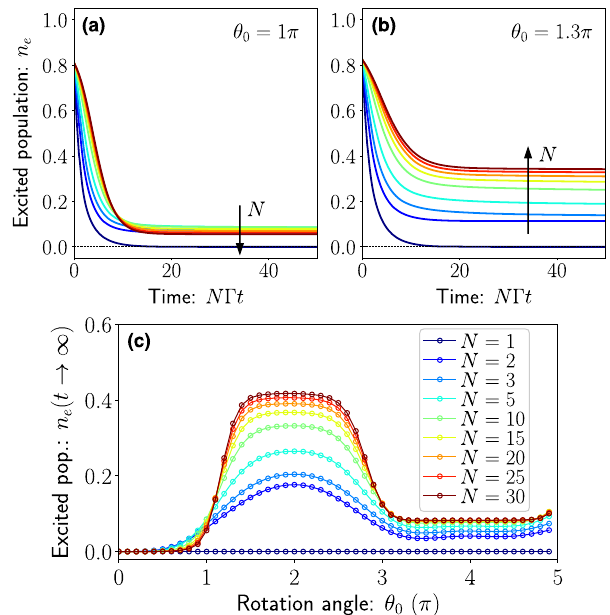
FIG. 5. N dependence of dark steady state. ED simulations for a 1 = 2 and F 3 = 2 which starts with six-level system with F ffiffiffi g ¼ e ¼ p − j g 2 all atoms in the ground state ðj g − 1 and is 1 = 2 i k Þ = = 2 i k ˆ H ˆ H Ω = 2 Þð ˆ R þ þ ˆ R − Þ excited with a exp ð − i τ Ω Þ pulse, where Ω ¼ ð and the pulse area is given by θ 0 ≡ j Ω j τ . (a),(b) Excited-state P 1 =N Þ population n h ˆ σ q e i as a function of the time N Γ t e ¼ ð m m e m for (a) θ 0 ¼ 1 π and (b) θ 0 ¼ 1 . 3 π . Different colors correspond to different system sizes N ; see legend in lower panel. (c) Value of the excited-state population n for t → ∞ as a function of the e pulse area θ 0 for different values of N . As N increases, the transition between different values of n for different θ 0 becomes e